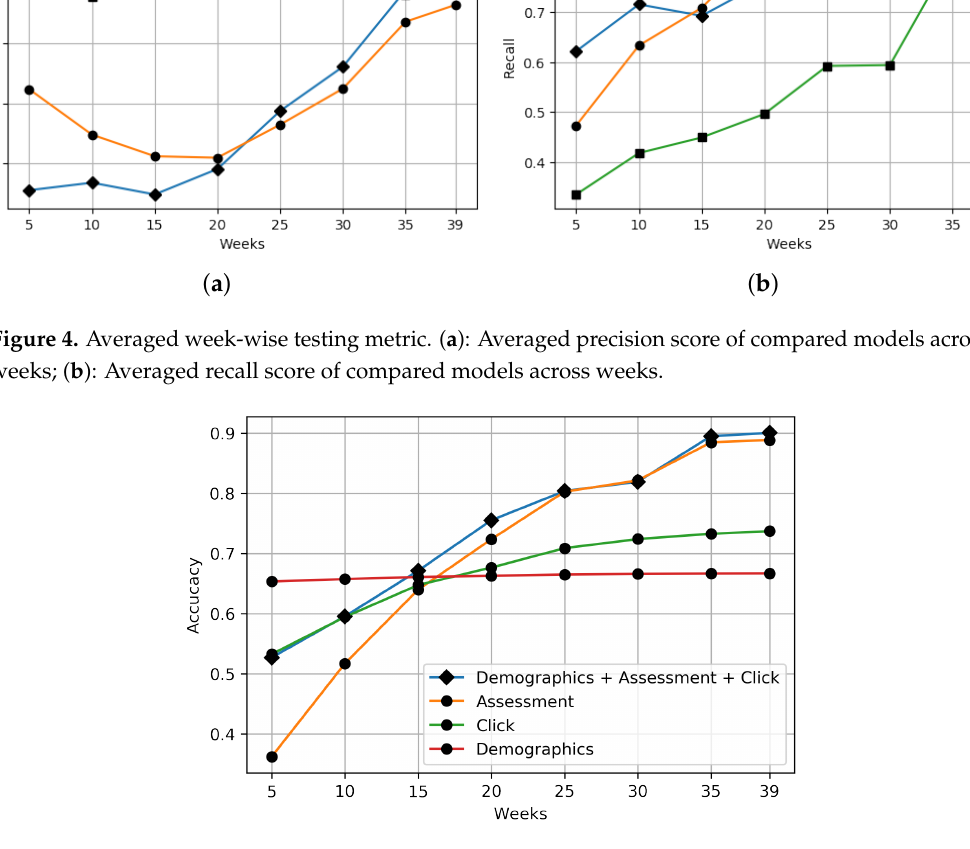
Figure 5. Comparison between models across different data